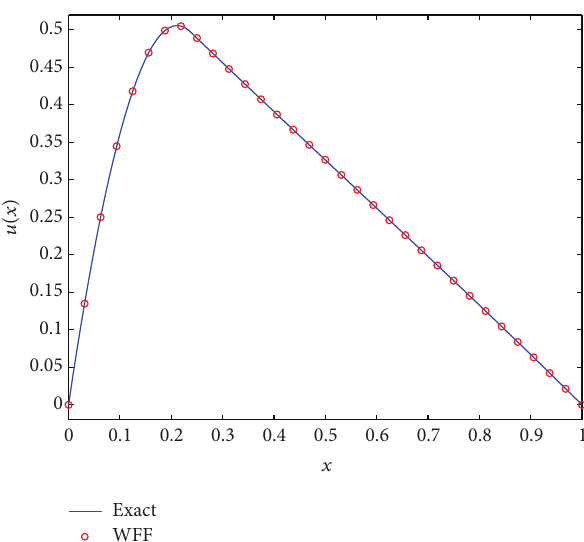
Figure 6: Solution of the BVP: using windowed Fourier